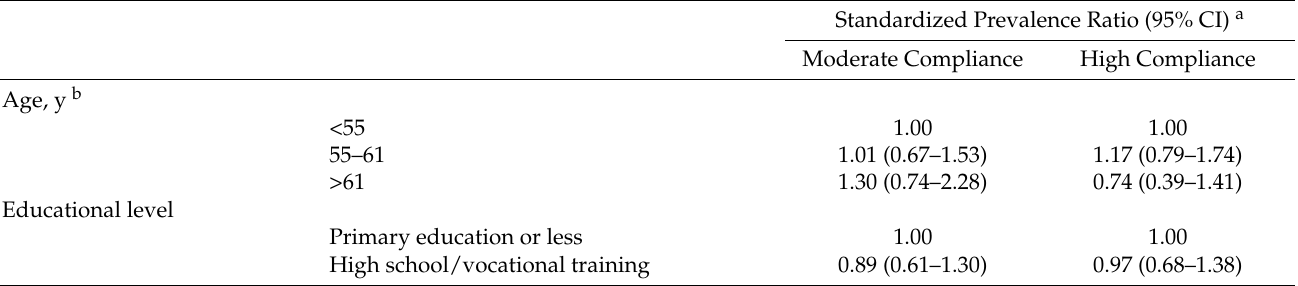
Table 3. Standardized prevalence ratios of moderate and high compliance with 2018 WCRF/AICR recommendations by sociodemographic and clinical characteristics of breast cancer